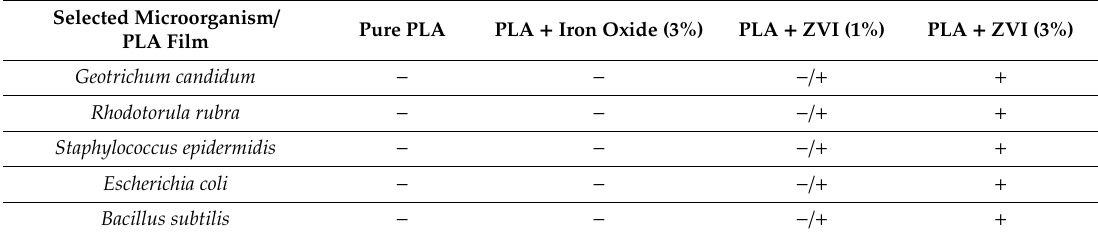
Table 3. Antimicrobial activity of pure PLA films and PLA films with the addition of iron oxide or ZVI (3% w / w ) towards selected